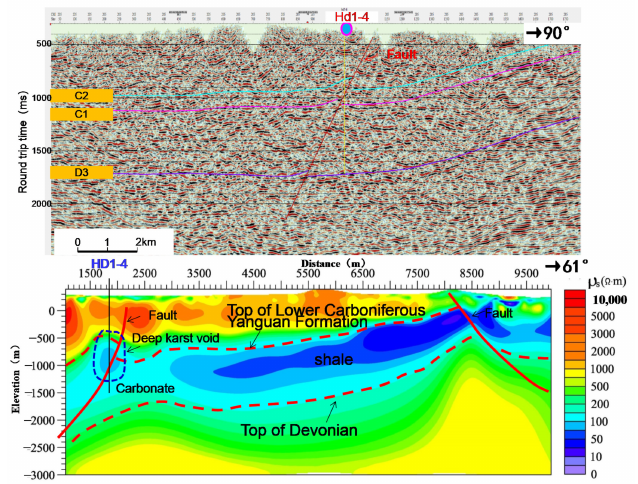
Figure 6. Geophysical identification of faults and caves in Huanjiang Sag. Above is the L2 2D Seismic Geological Interpretation Profile; the seismic section near Well HD 1-4 are discontinuous, indicating a presence of a reverse fault there in combination with drilling cores; below is the GY-1 wide-field electromagnetic geological interpretation section; in the high-resistivity strata, low-resistivity geolog- ical bodies are developed near HD1-4, which was confirmed to be a karst space in combination with drilling cores. Note: The plane locations of the geophysical L2 and GY-1 lines are shown in Fig- ure 1B, and the uninterpreted seismic profile of L2 is shown in Supplementary Material Figure S5. C2 = Top of Lower Carboniferous Yanguan Formation, C1 = Top of Devonian, D3 = Top of Middle